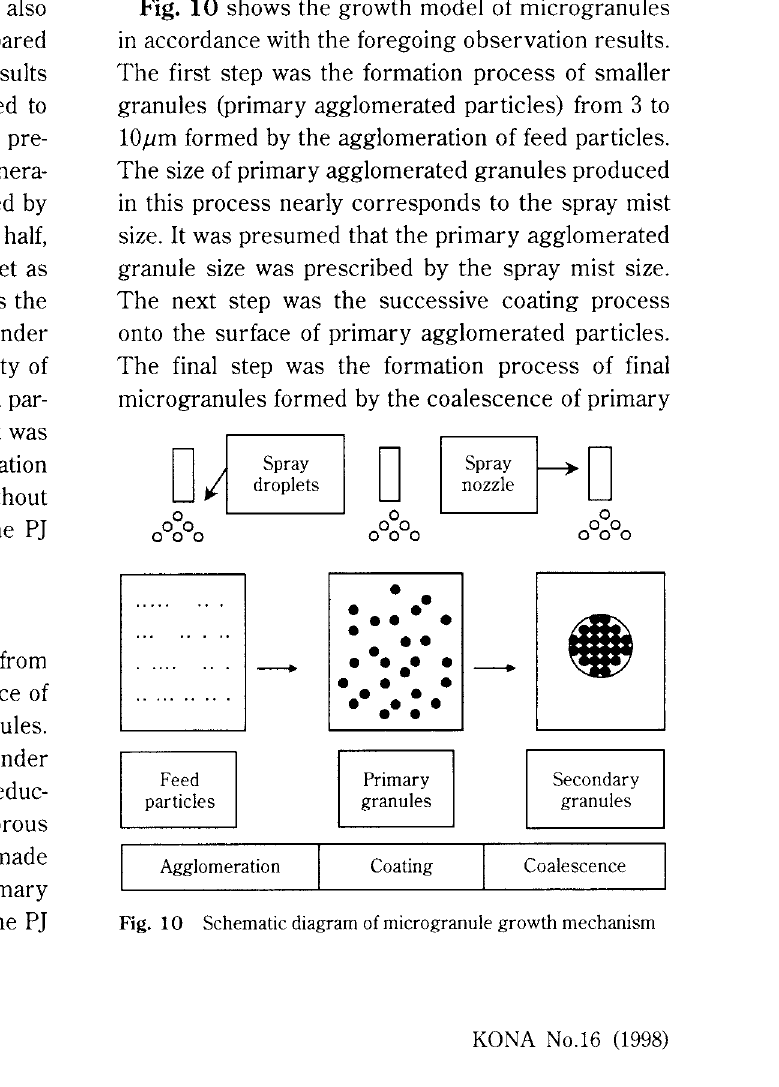
55,um Fig. 9 SEM photographs of microgranules obtained in R-4 and R-6 ( ..__....; scale) (c-1): R-6, Products under 25,um (c-2): R-6, Products from 45 to 75,um (c-3): R-6, Products from 45 to 75,um (d-1): R-4, Products from 45 to 75,um